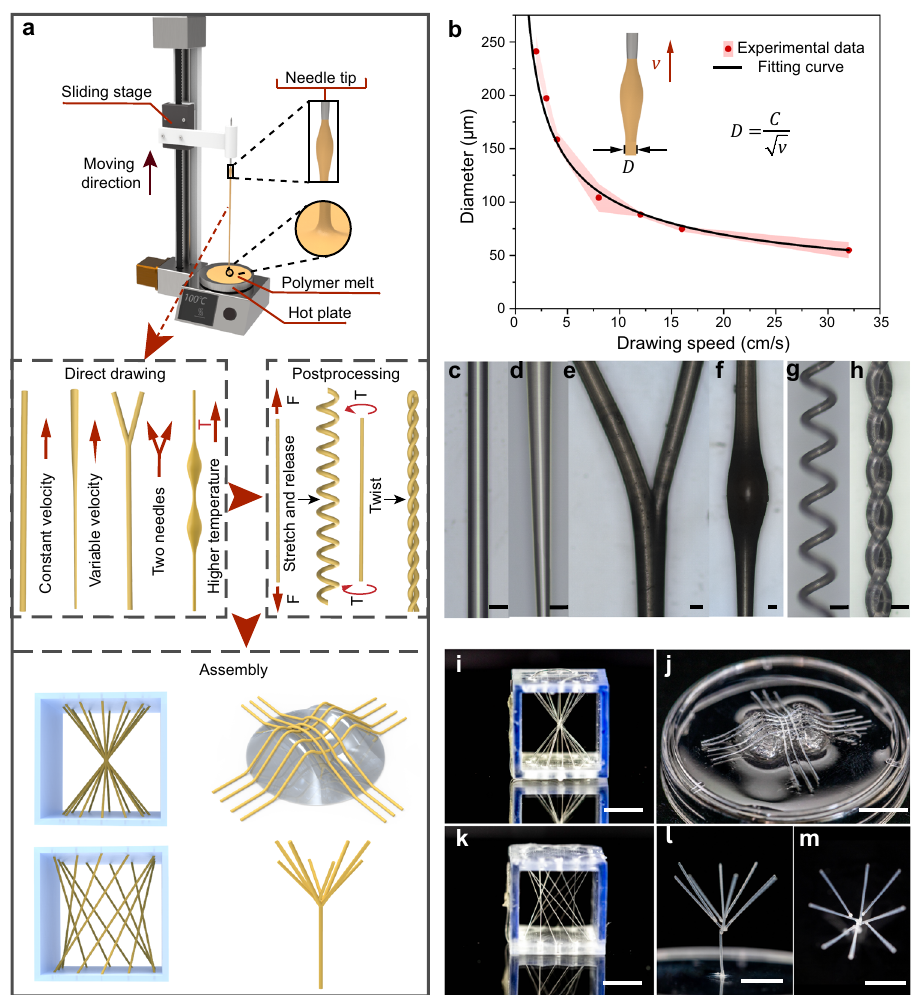
Fig. 2 | Fabrication methods of soft templates and the resultant prototypes. a The fabrication methods for the soft templates, including direction drawing, postprocessing,andassembly.Aseriesofshapesandgeometriescanbegenerated by varying the parameters in each step. b The relationship between fi lament dia- meter D and drawing speed v ( C is a constant). The red dots and pink cloud representthemeanvaluesandstandarddeviations. c – h Softtemplatesofdifferent